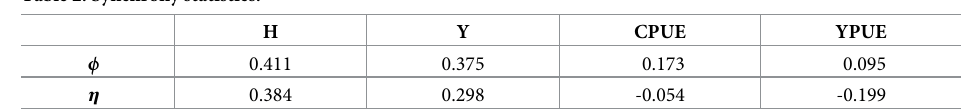
Fig 3. Catch and income per unit of effort, 2002-2018. https://doi.org/10.1371/journal.pone.0271172.g003 Table 2. Synchrony statistics.